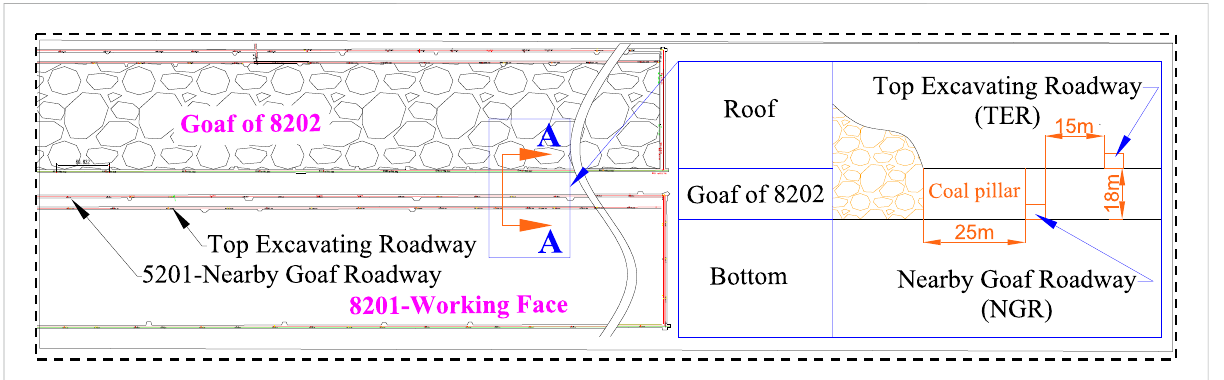
FIGURE 1 Position of the 5201-nearby goaf road.